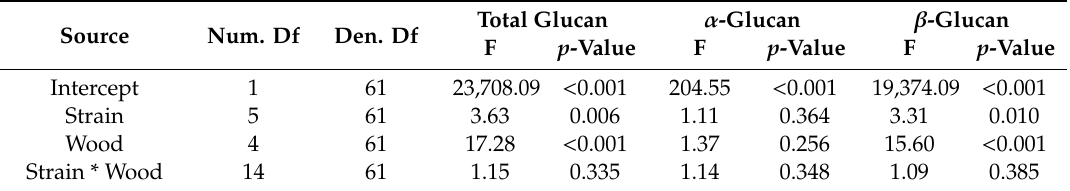
Table 3. E ff ect of the factors strain and wood on the total glucan, α -glucan and β -glucan content of Table 3. Effect of the factors strain and wood on the total glucan, α -glucan and β - glucan content of G. G. lucidum fruiting bodies of the substrate bags treated at + 5 ◦ C (Equation (3), Type III test).